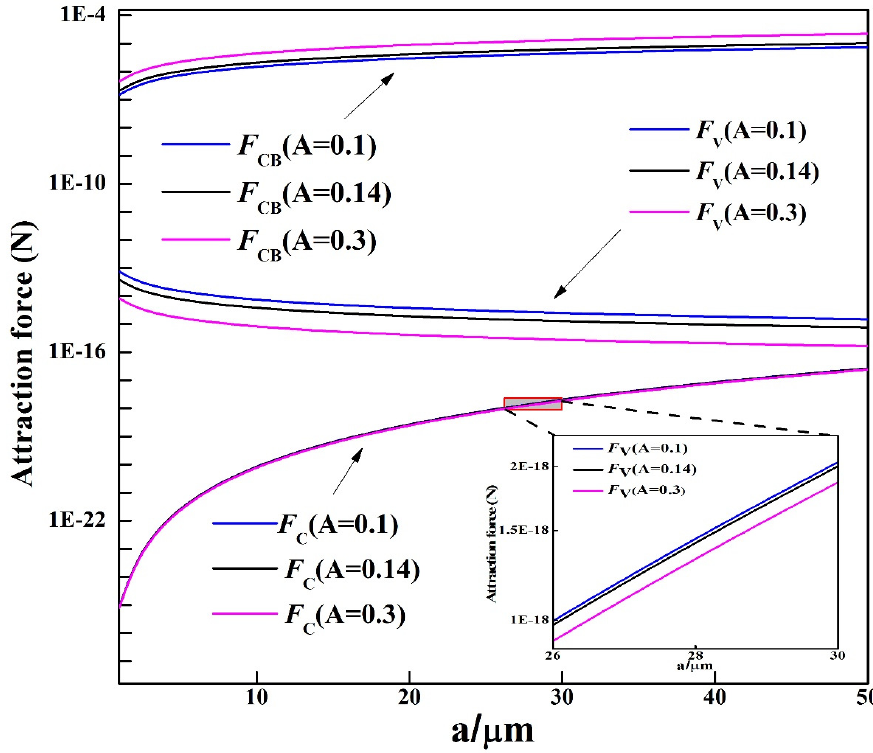
Figure 7. Relationship of van der Waals force, capillary force, cavity bridge force with particle side length.